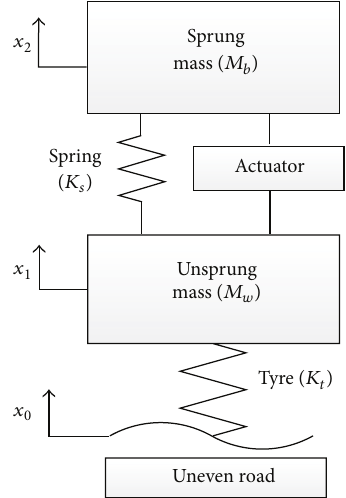
Figure 1: Quarter car model of active